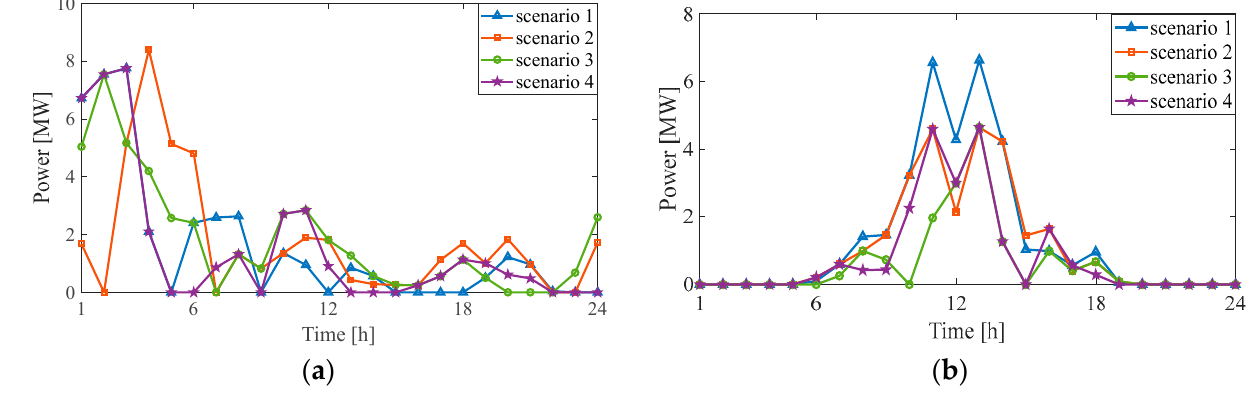
Figure 5. Output power under typical scenarios: ( a ) WG; ( b ) PV.